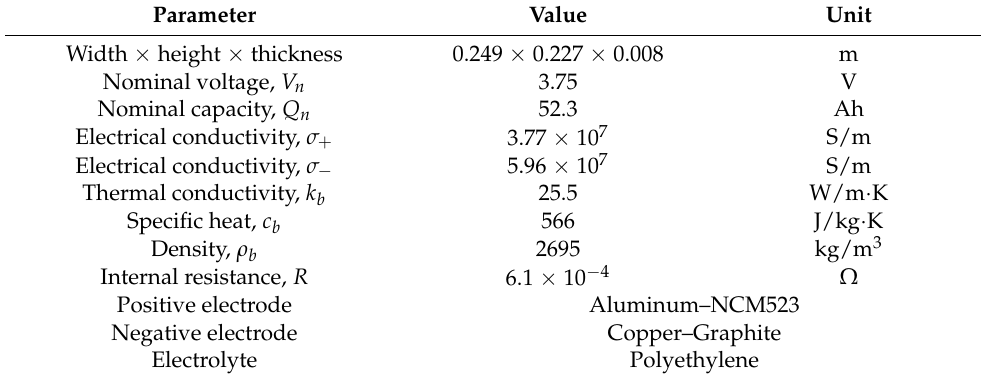
Table 1. Battery specifications.